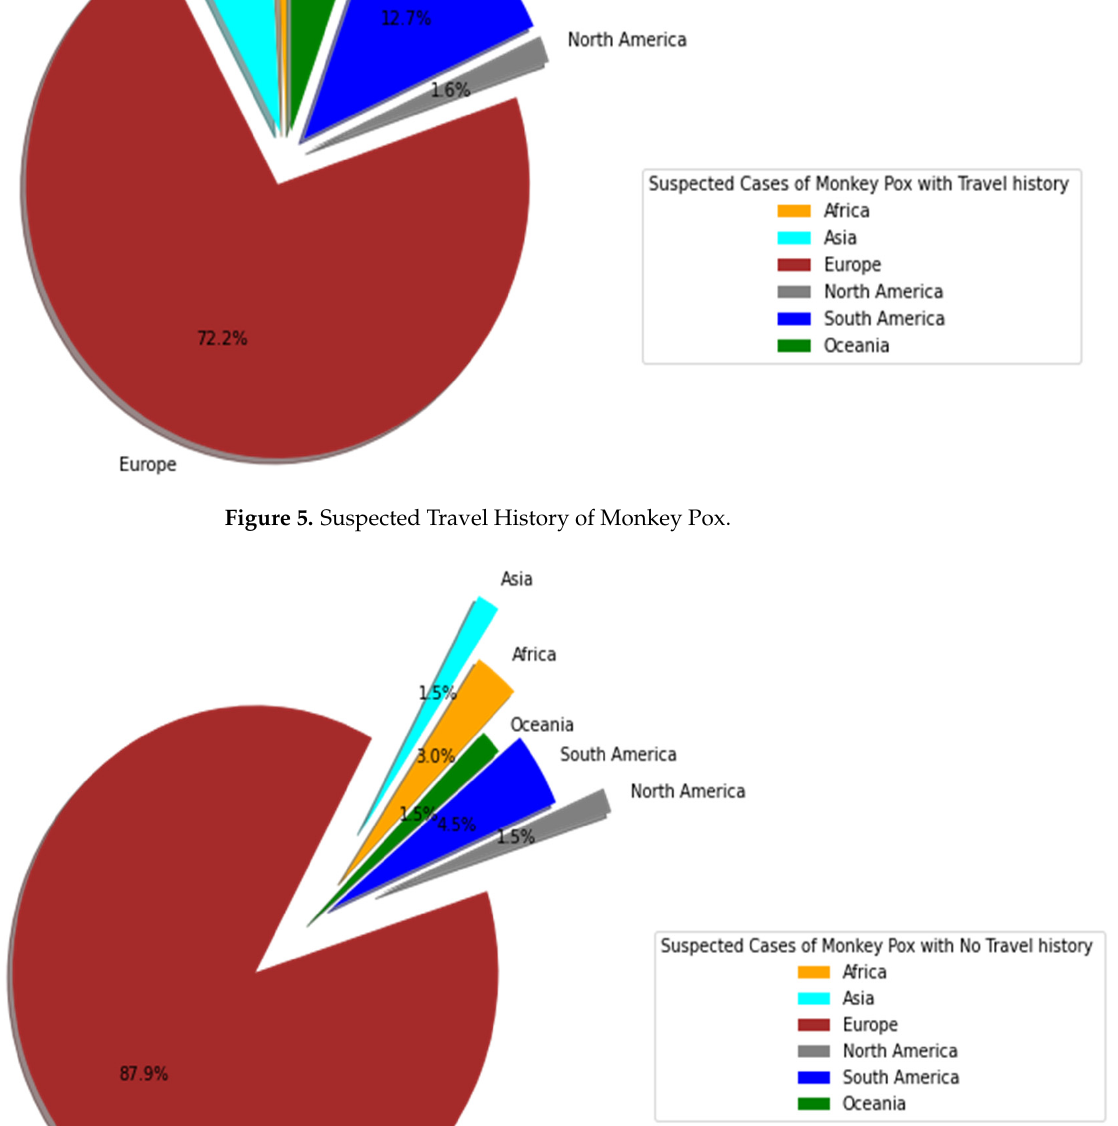
Figure 6. Suspected Cases of Monkey Pox with No Travel History.